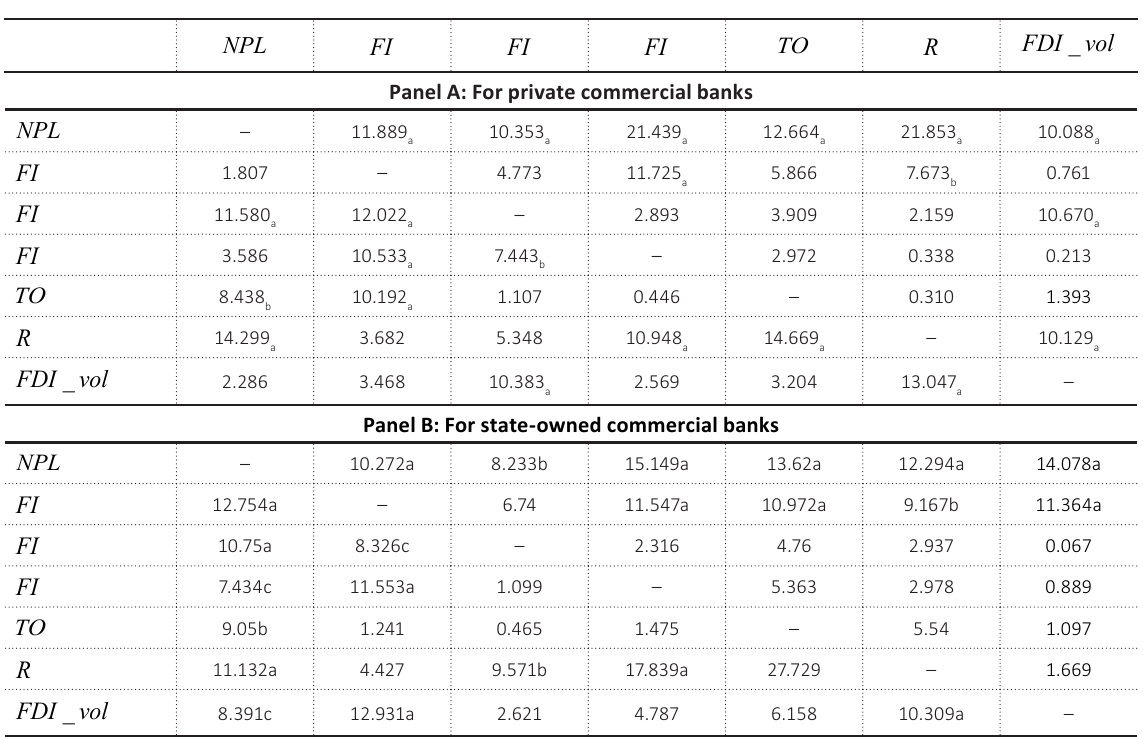
Table 8. Toda-Yamamoto causality test results